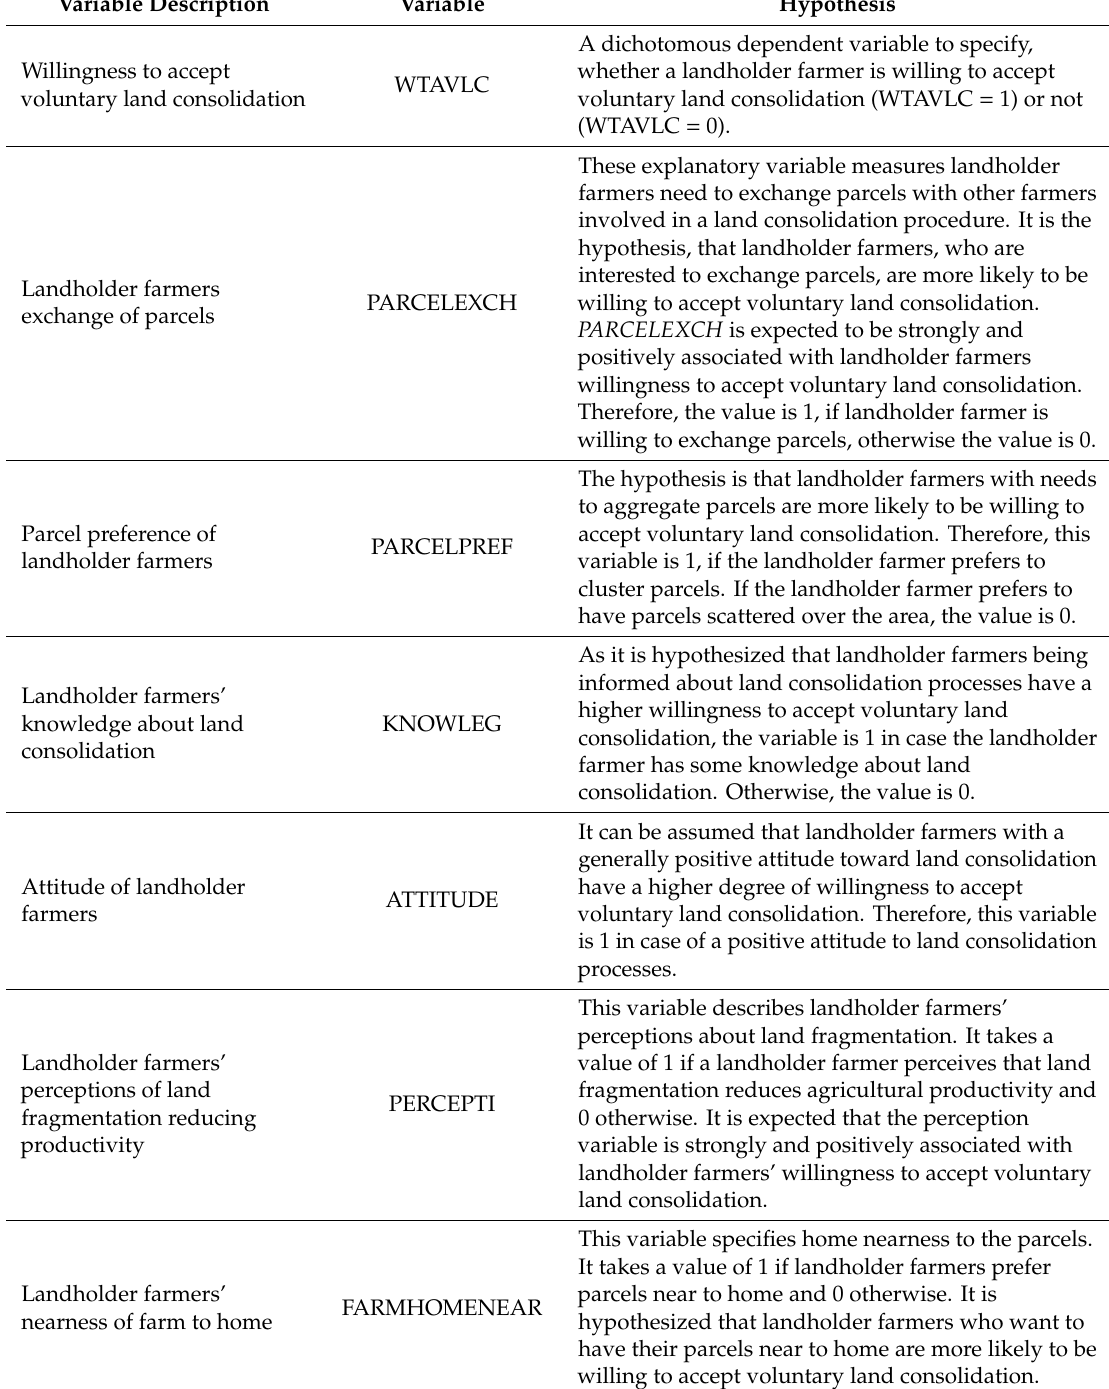
Table A1. Variables specification and working